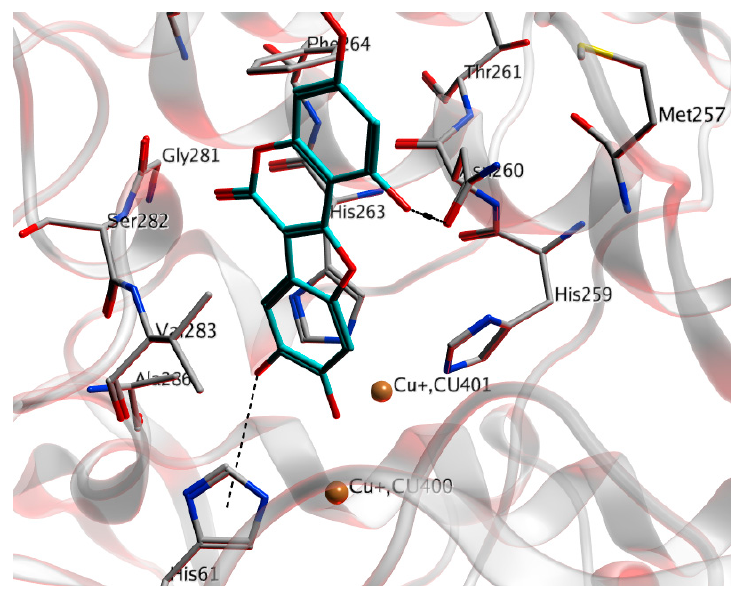
Figure 3. Computational docking simulations between tyrosinase and WEL obtained using GOLD5.1. The cyan stick structures indicate WEL and the white stick structures represent the amino-acid residues of tyrosinase. The copper ions are depicted as yellow balls. The black dotted lines represent hydrogen